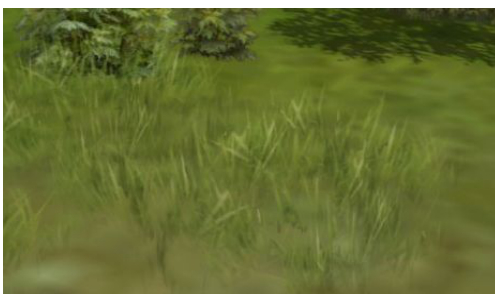
Figure 5. Manual-surface Plant